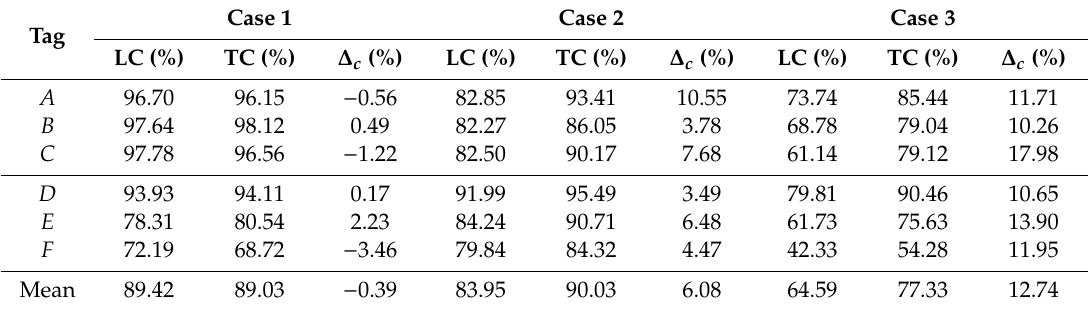
Table 7. Comparison of correctly fixed ambiguity rates between LC and TC under different scenarios and the corresponding differences.